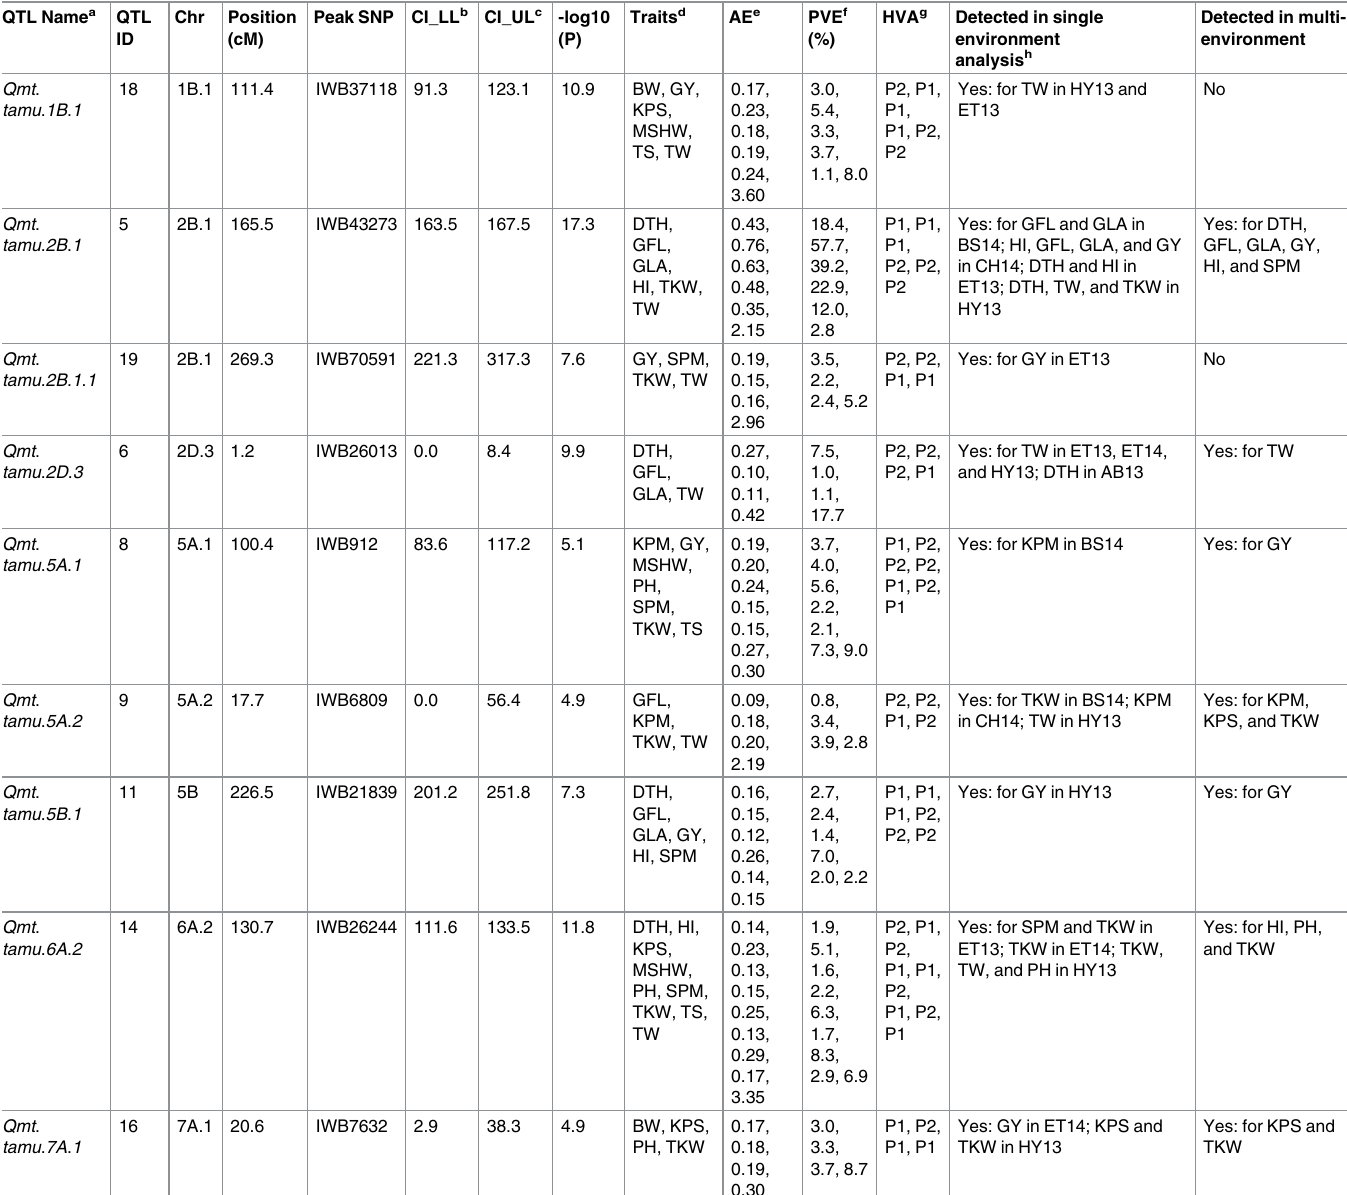
Table 2. Multitrait QTL detected using data pooled across